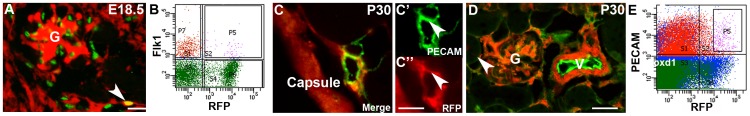
Stromal derivatives form endothelium that is present in peritubular capillaries.
A. IF in E18.5 Foxd1creCAG mouse section reveals RFP stromal derivatives (red) that co-label with Erg (green) in a peritubular capillary (arrowhead); in the glomerulus (G), the stromal-derived cells form the mesangium (red) but do not express Erg (green). B. Flow sorted kidneys from E18.5 Foxd1creCAG reporter mice show co-expression of RFP (Foxd1-stromal derivative, X axis) and Flk1 (Y axis) in a subset of cells (P5). C-C’’. IF in a P30 Foxd1creCAG kidney section reveals a peripheral peritubular capillary with co-expression of RFP stromal derivatives (red) and PECAM (green) (arrowhead). D. IF from a P30 Foxd1creCAG kidney section shows a glomerulus (G) and major vessel (V), that express RFP stromal derivatives in the mesangium and vascular smooth muscle (red), respectively, but that do not co-express RFP and PECAM (green) in endothelium in those tissues. E. Flow sorted kidneys from P30 Foxd1creCAG reporter mice show that many RFP stromal derived cells (X axis) co-express PECAM (Y axis) as shown in P5. Scale bars A = 30 µm, C = 20 µm, D = 50 µm.